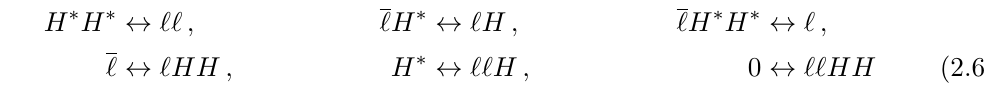
Figure 1 . The true vacuum ( of the bubble wall and its expansion velocity are denoted as L w and v w